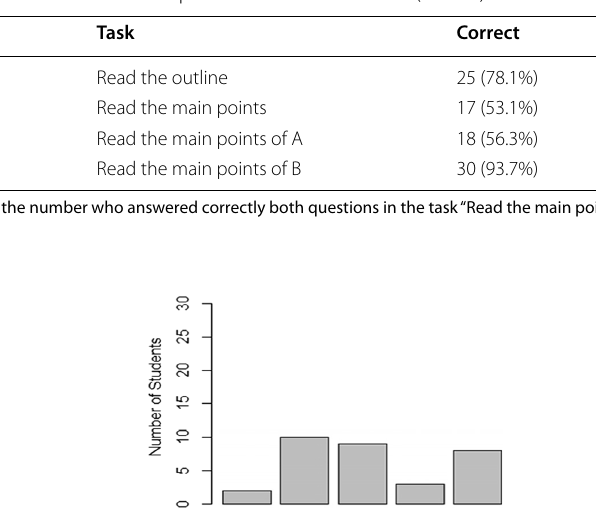
Table 5 Correct and incorrect responses in Screens 3 and 4 ( N